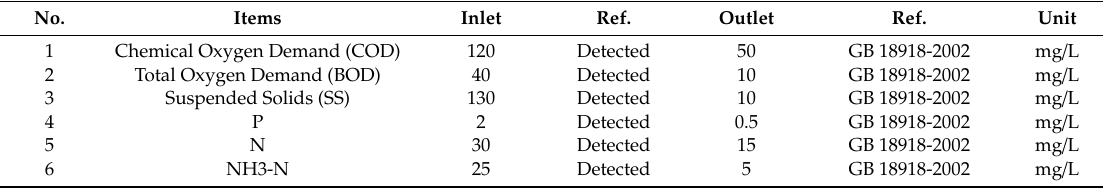
Table 6. Water-quality discharge from import and export